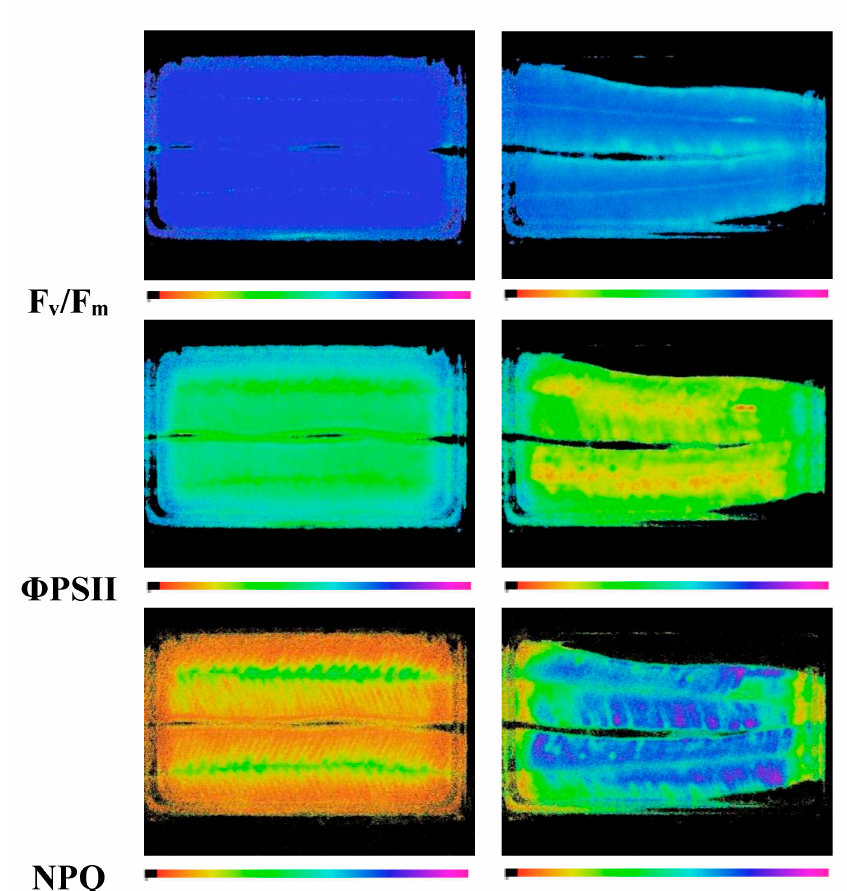
Figure 4. Chlorophyll fluorescence images of photochemistry (F v / F m ) in a dark-adapted leaf and PSII photochemistry ( Φ PSII) and non-photochemical quenching (NPQ) at steady-state with actinic illumination of 150 µ mol photons m − 2 s − 1 in control and arsenic-treated leaves of Pteris vittata measured at the end of the experiment. The false color code depicted at the bottom of the images ranges from 0.00 (black) to 1.00 (pink).